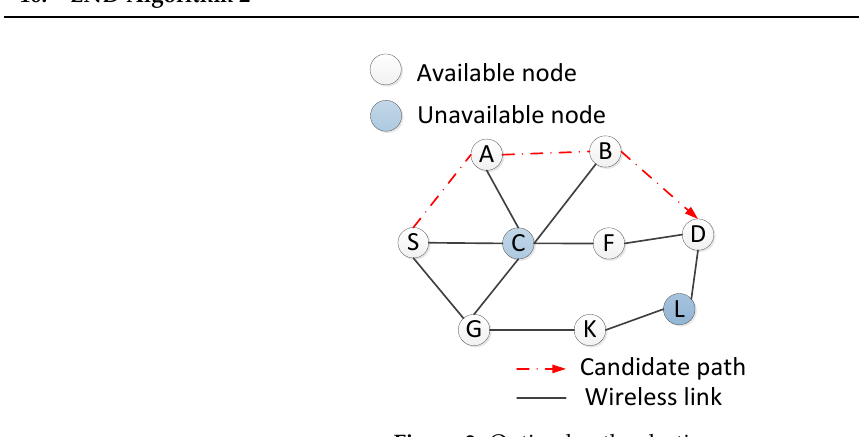
Figure 3. Optimal path selection.